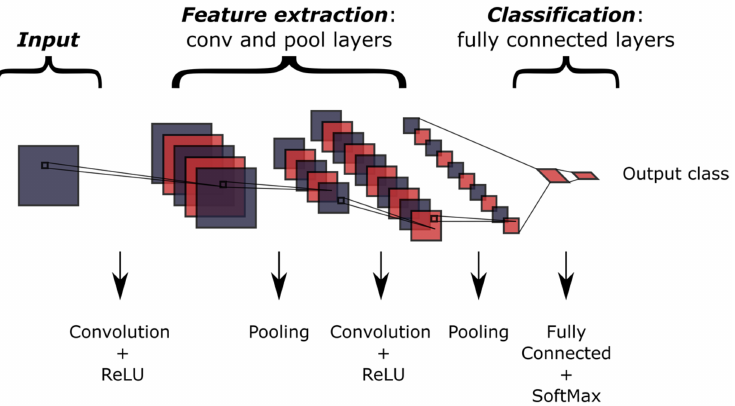
Figure 1. General architecture of a